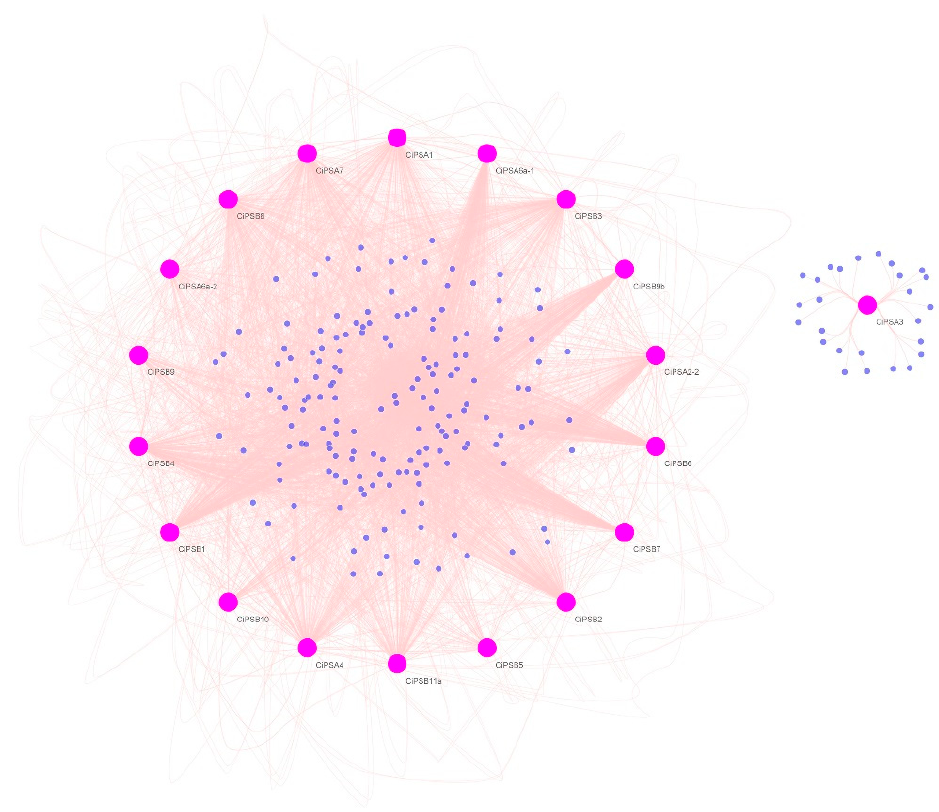
Figure 4. Gene regulatory network analysis of CiPS gene family members in grass carp.